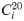
(a) Scatterplot of 20-year citations, Ci20, versus their PACS entropy, Ii. To control for the strong correlation between Ii and the length of reference list, Li, (ρ = 61), see (b), we show the PACS entropy per reference, Ii/Li, in (c). The effect seen in (a) has vanished and is reversed. Only those 2, 491 papers where enough PACS information is present were considered, see Methods.